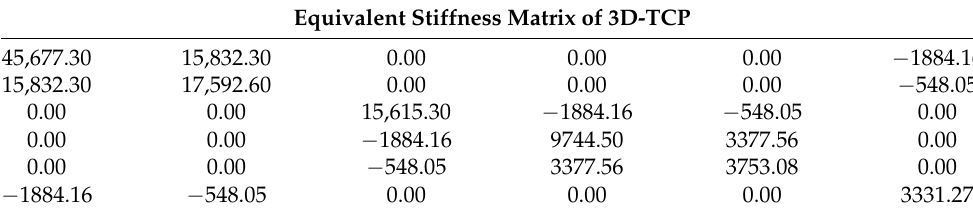
Table 14. Equivalent stiffness matrix of 3D-TCP (unit: